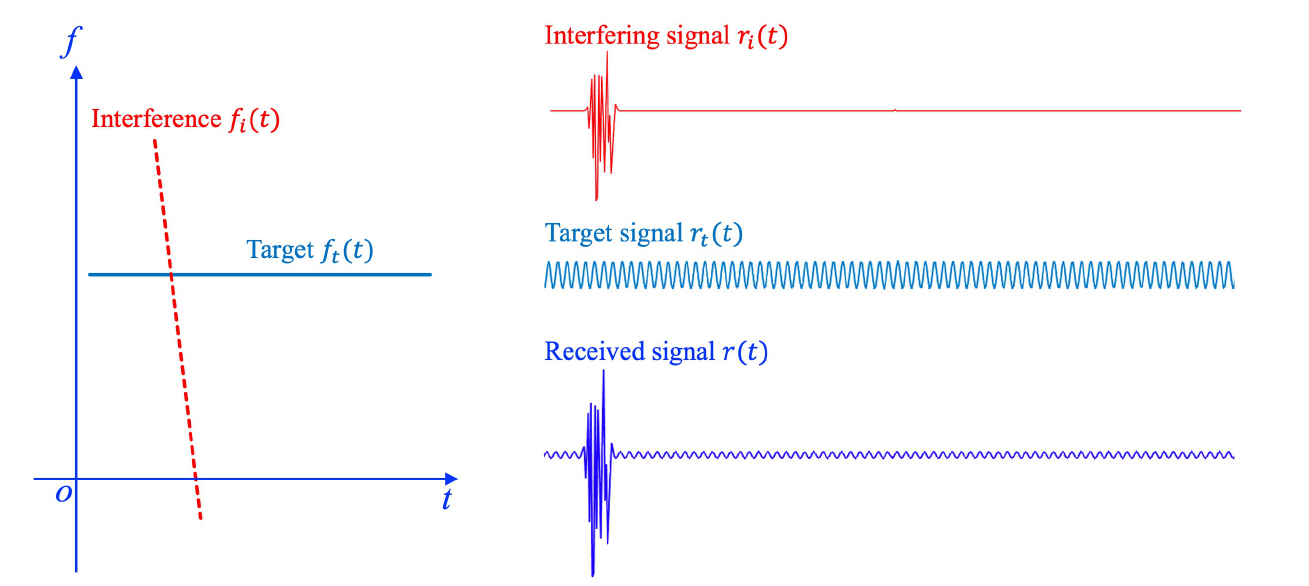
Figure 1. Demonstration of incoherent